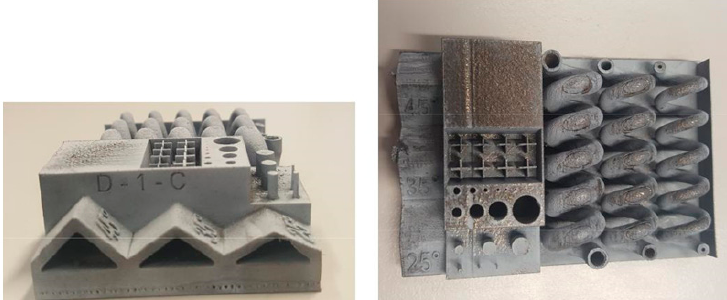
Figure 24. Observed defects on the spiral samples: pyramids from company D, first job, C sample ( left ); recoater issue from company D, first job, T sample ( right ). ( left ); recoater issue from company D, first job, T sample ( right ).